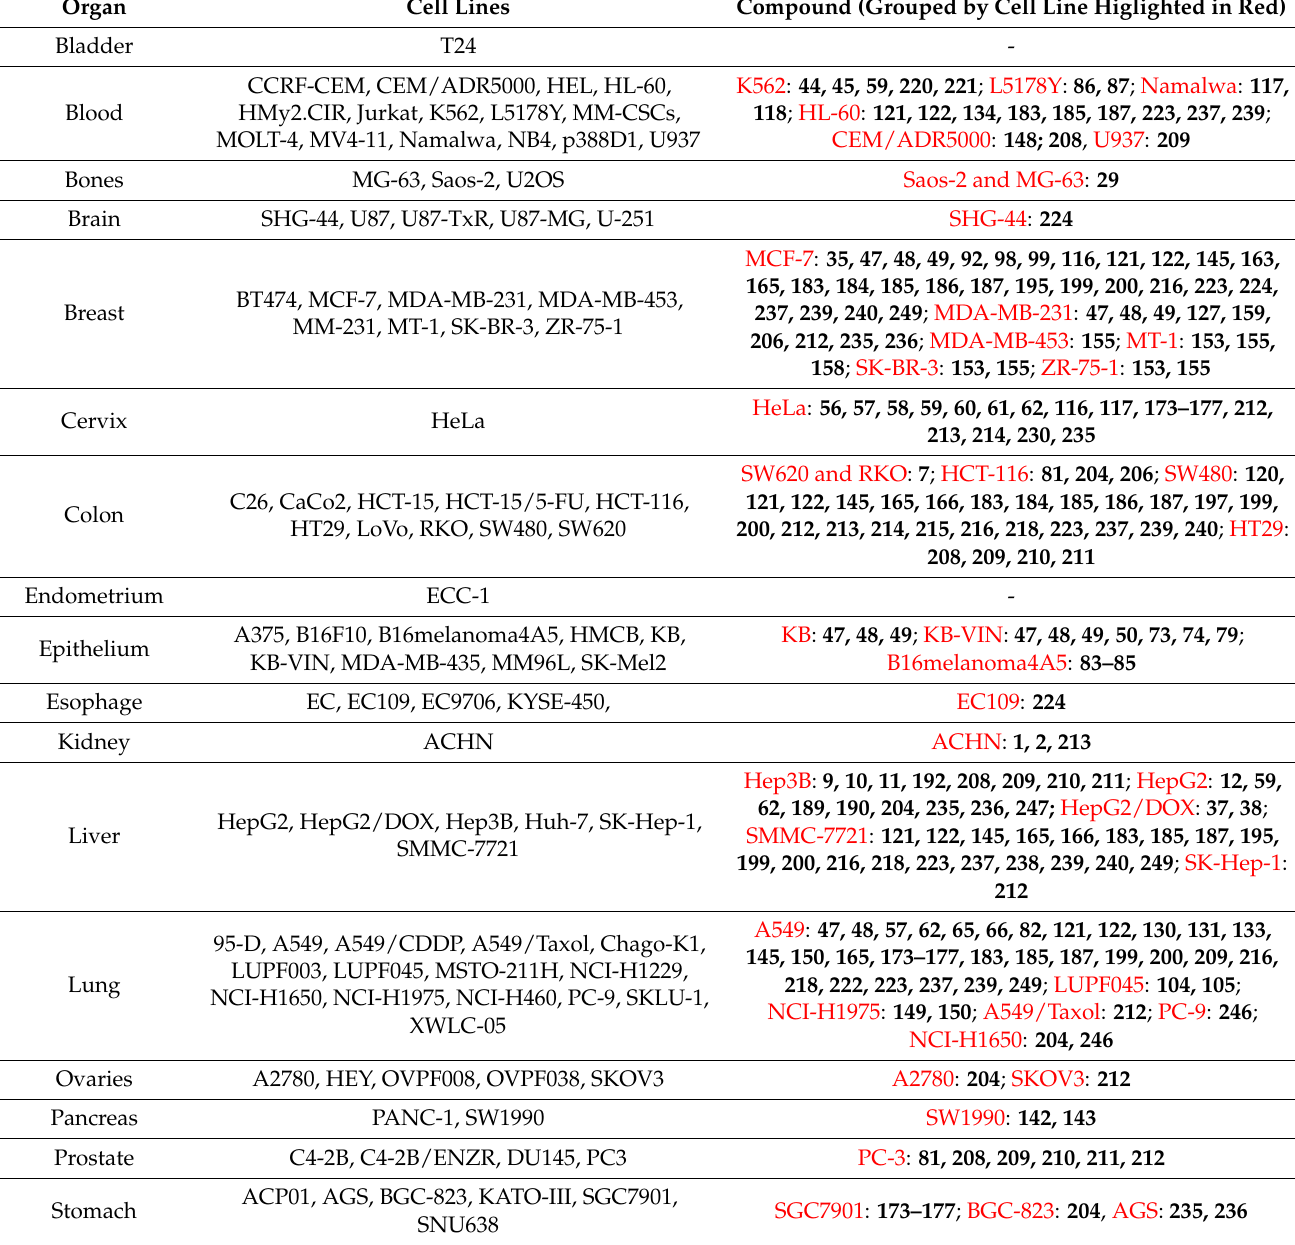
Table 2. Cell lines and compounds which showed better activity than the positive control.